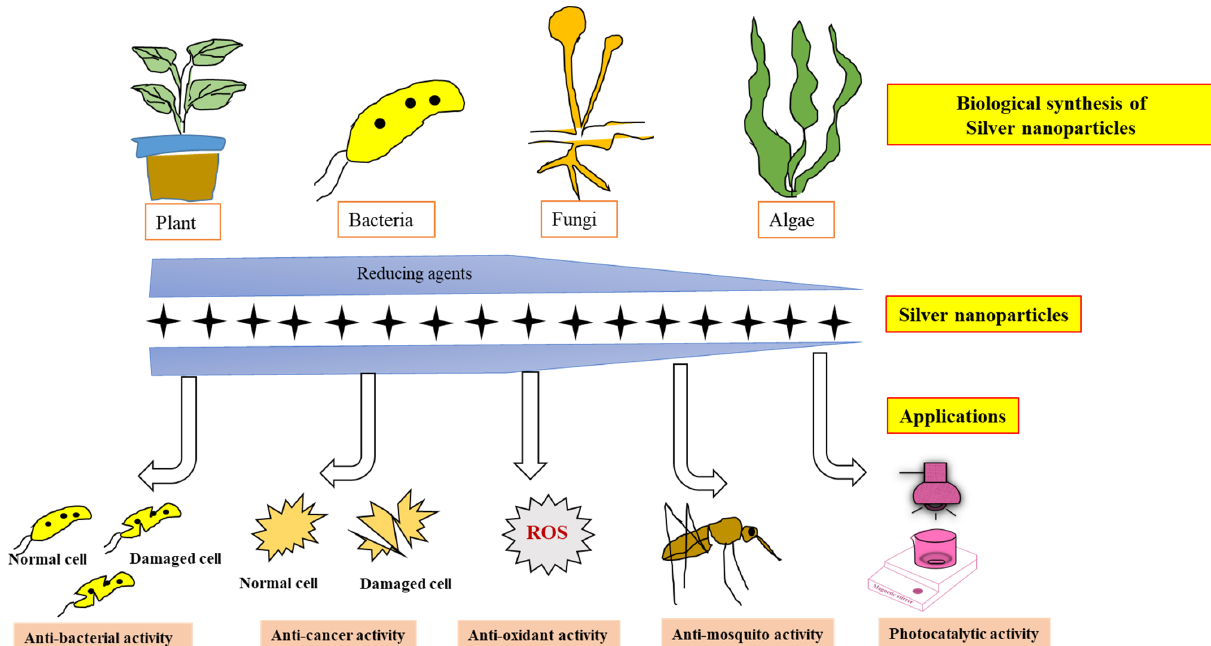
Figure 5. Schematic representation of types of biological AgNPs synthesis methods and their appli ‐ cations.